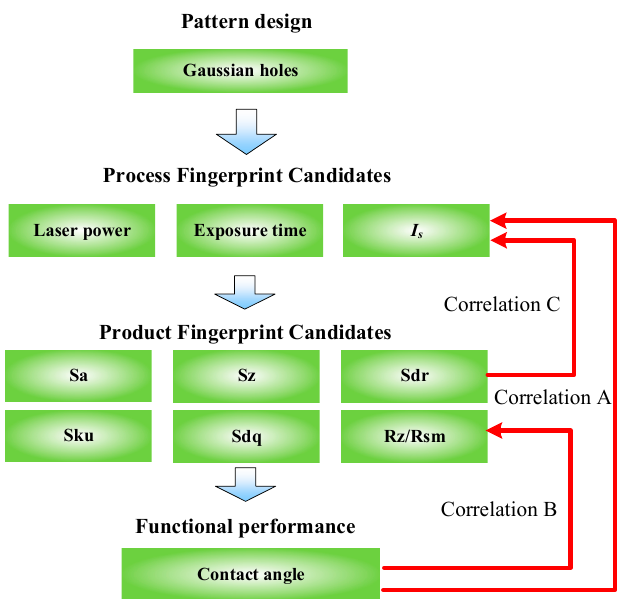
Figure 1. Concept of the process and product fingerprints in laser ablation of the superhydrophobic surface.